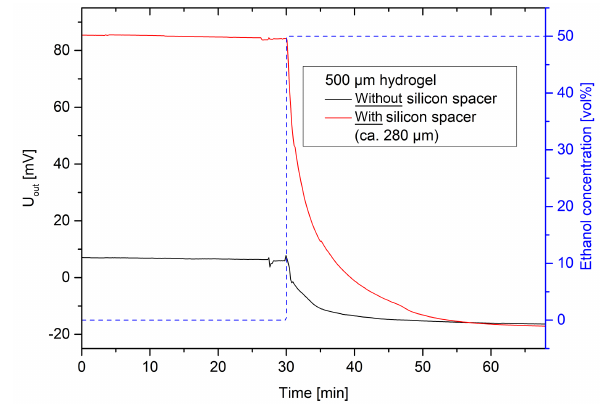
Figure 10. Influence of the sensor setup on the output signal (hy- drogel: 10vol%Aam and